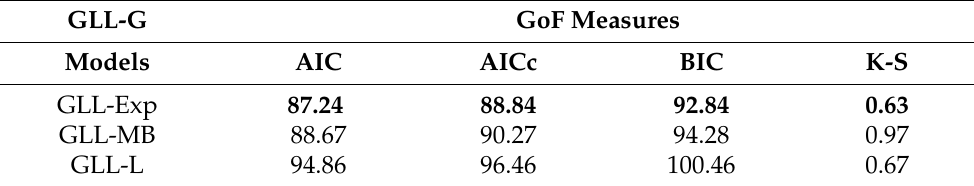
Table 4. Goodness-of-fit for the selected